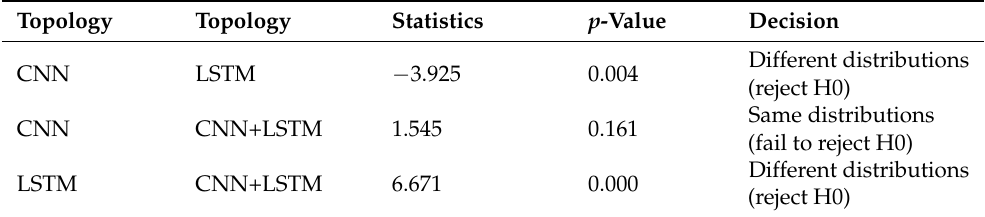
Table 9. Significance